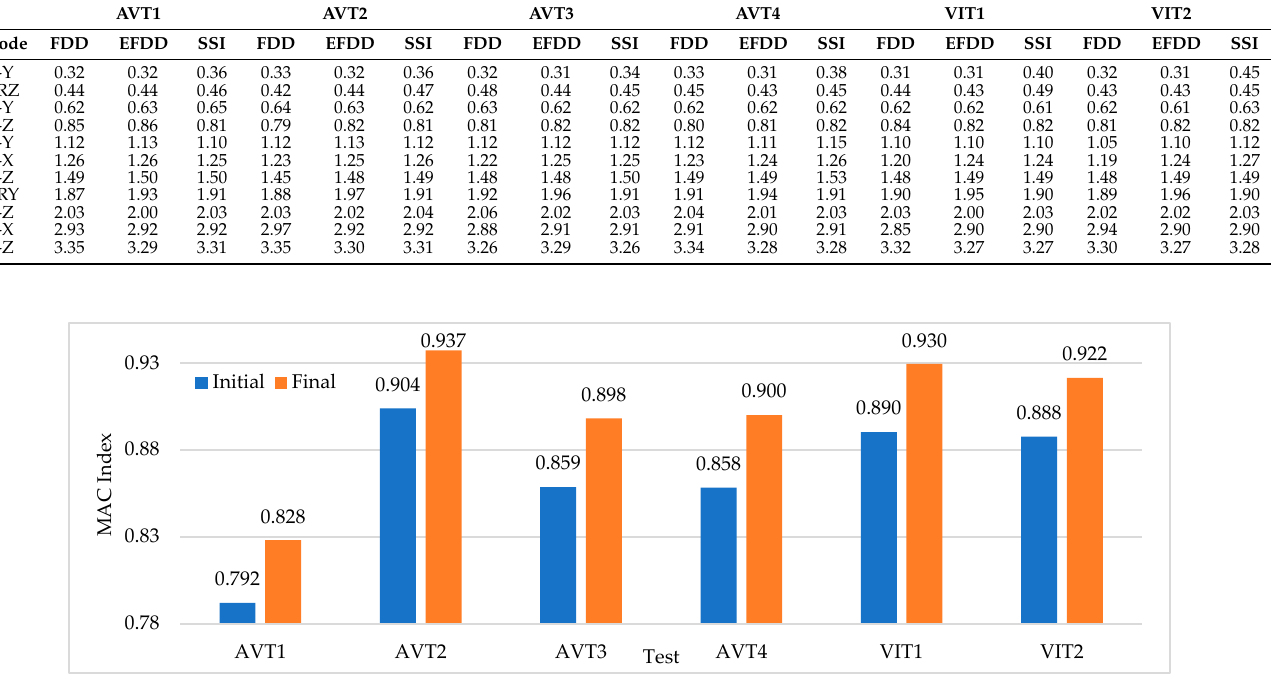
Figure 16. Variation of the MAC index due to update of the FE model.